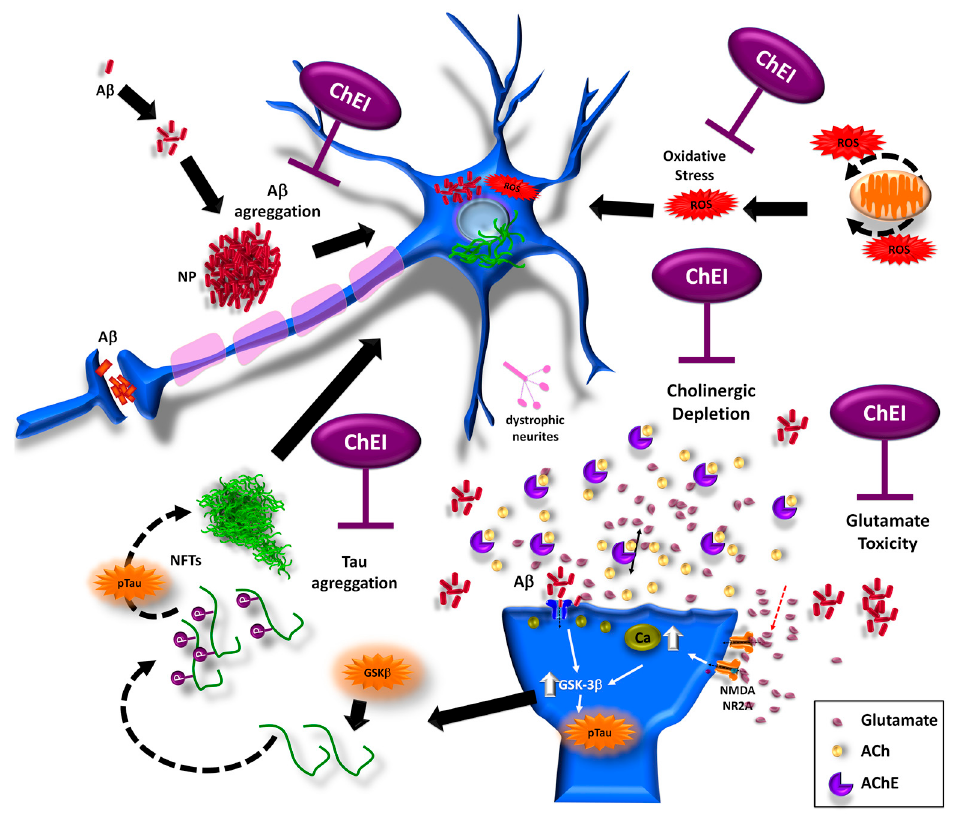
Figure 6. Neuroprotective effects of AChE inhibitors. Acetylcholine (ACh) is one of the main neurotransmitters, released at the synapse, and broken down by the enzyme acetylcholinesterase (AChE) into choline and acetate. The excess of AChE generates a cholinergic depletion, generating damage at the synaptic level and degeneration of cholinergic projections in the basal forebrain that leads to cognitive impairment. ChEIs reduce neuronal death caused by PNs and MNFs formation, decrease glutamate-mediated toxicity, cholinergic depletion, phosphorylated tau aggregation, ROS damage, and decrease amyloid levels.